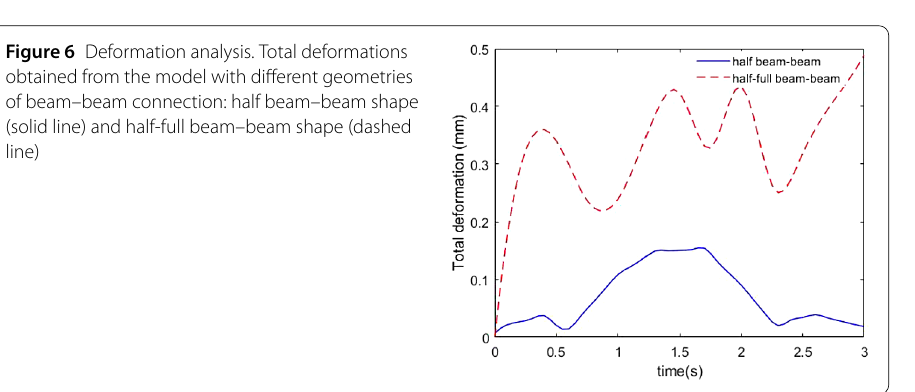
Figure 6 Deformation analysis. Total deformations obtained from the model with different geometries of beam–beam connection: half beam–beam shape (solid line) and half-full beam–beam shape (dashed